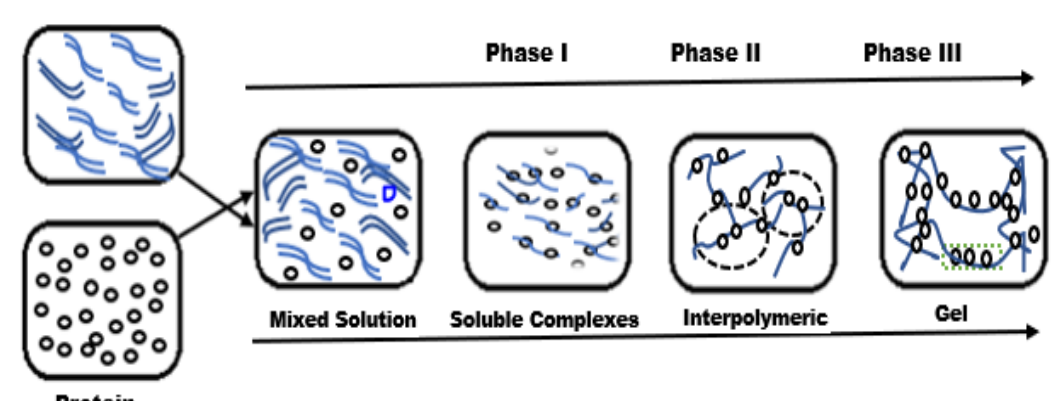
Figure 4. Formation of protein – polysaccharide gel complexes at different stages (reproduced with permission from [102] Copyright Elsevier,